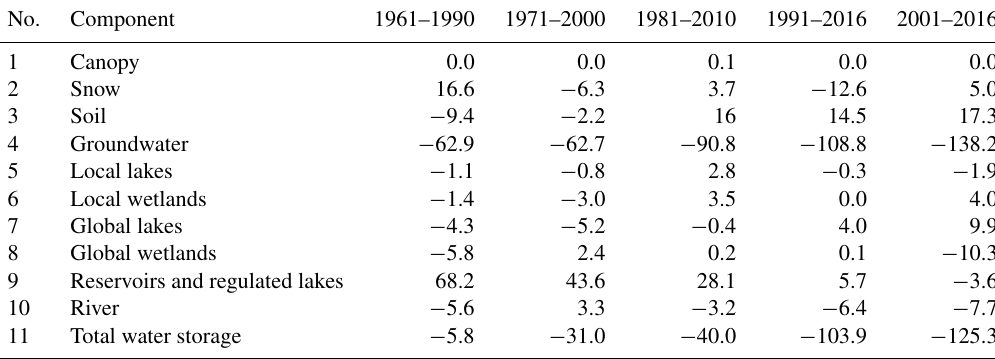
Table 7. Globally aggregated (excluding Antarctica and Greenland) water storage component changes during different time periods as simulated by WaterGAP 2.2d. All units in km 3 yr − 1 .